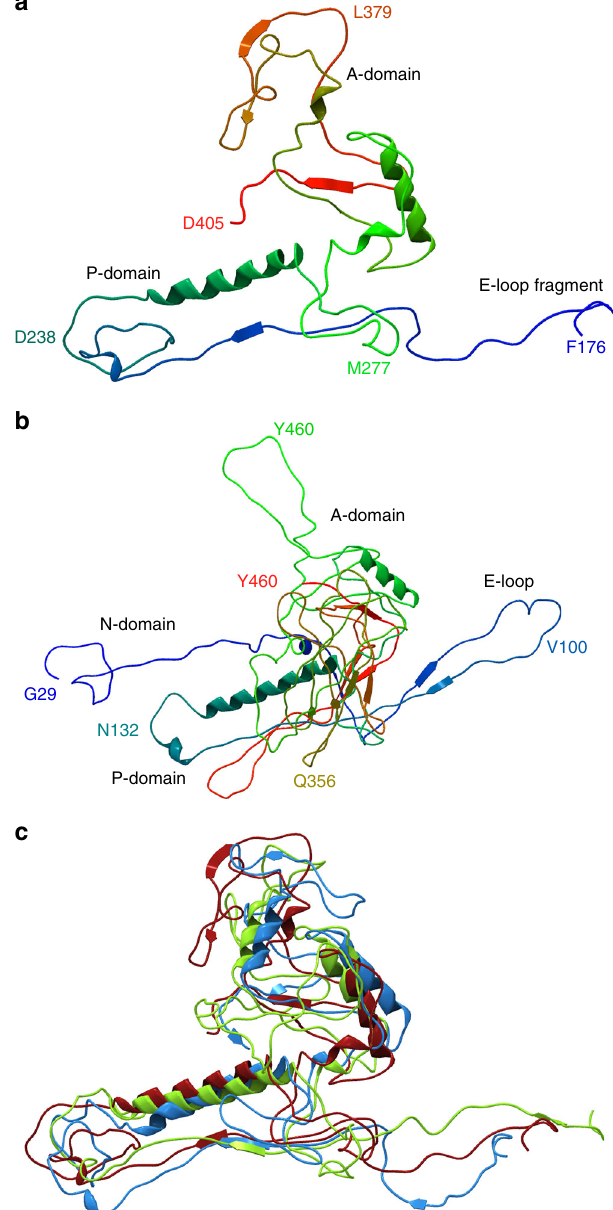
Fig. 2 Predicted tertiary structure of Φ crAss001 major capsid protein (MCP). a Homology-based modelling of aa 176405 fragment of Φ crAss001 MCP. A-domain, axial domain; P-domain, peripheral domain; N-terminal domain and E-loop could not be resolved due to lack of similarity with the used template; colour gradient re fl ects aa position in the sequence (blue to green to red from N terminus to C terminus). b Staphylococcus phage 812 MCP (PDB 5LII [https://www.rcsb.org/structure/5LII] 40 ) used as template in HHPred-MODELLER suit (HHPred probability score 96.87%, e - value 0.00081). c Superposition of φ crAss001 MCP model (red) with p- crAssphage (green) and IAS virus (blue) MCP models (probability scores against PDB 5LII [https://www.rcsb.org/structure/5LII] 99.37, 96.89%, e - values 4e-14, 0.00063,